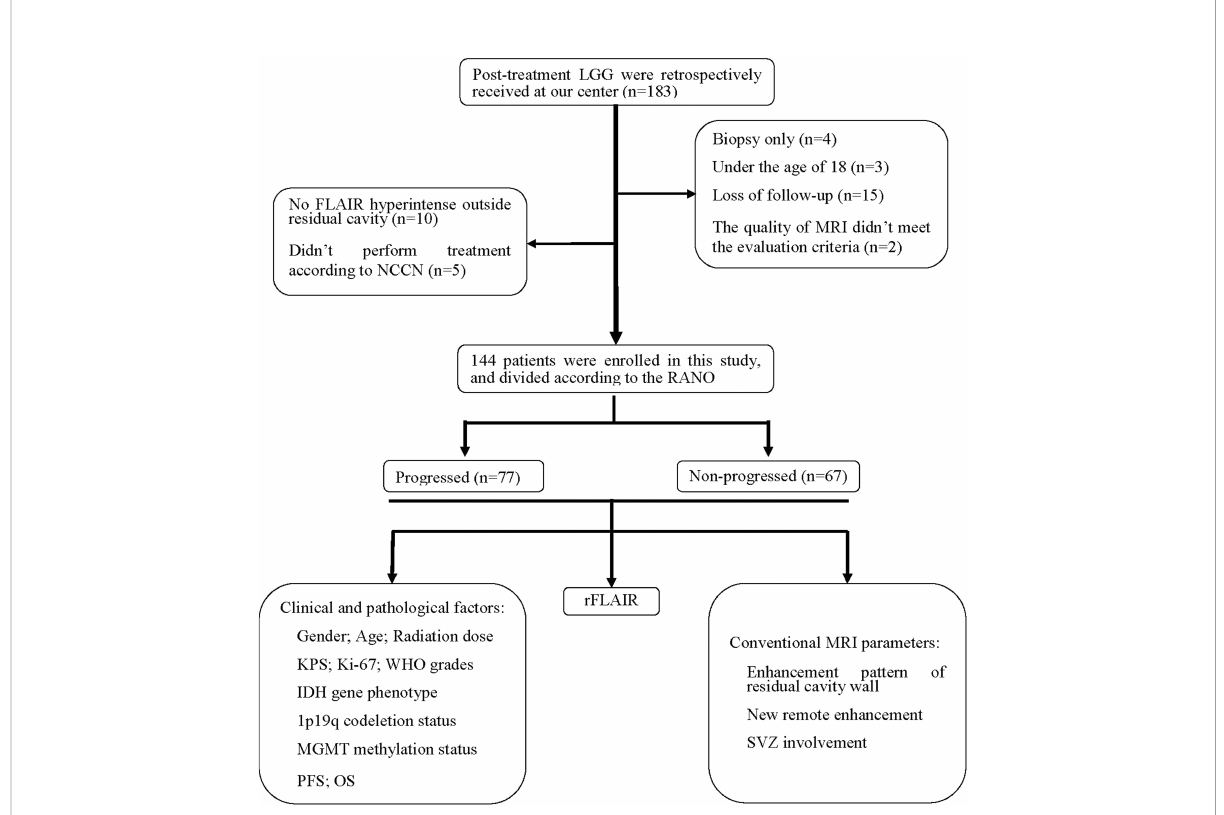
FIGURE 1 Patient fl owchart. IDH, isocitrate dehydrogenase; KPS, Karnofsky Performance Scale; LGG, lower-grade glioma; MGMT, oxygen 6- methylguanine-DNA methyltransferase; NCCN, National Comprehensive Cancer Network; OS, overall survival; PFS, progression-free survival; RANO, Response Assessment in Neuro-Oncology; rFLAIR, relative FLAIR; SVZ, subventricular